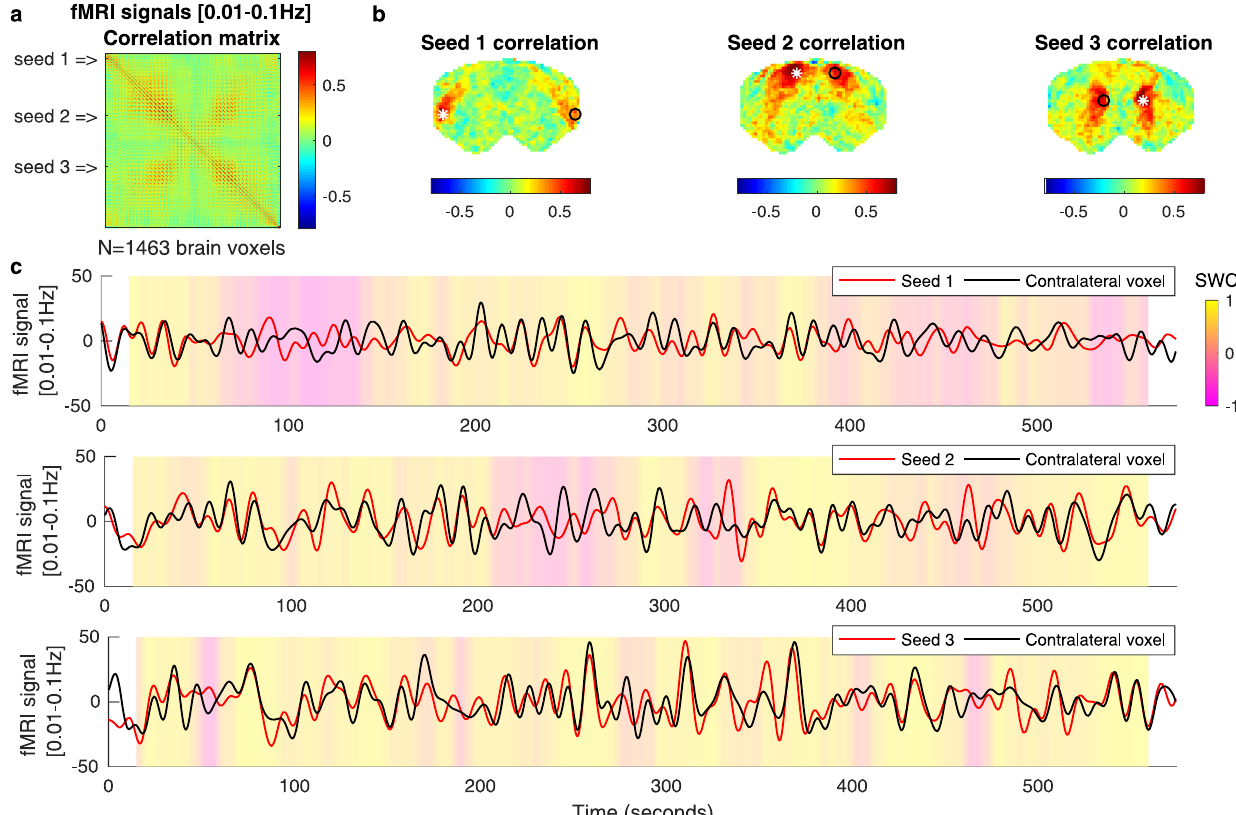
Fig. 1 | Static and dynamic resting-state functional connectivity analysis in band-pass fi ltered fMRI signals. a Correlation matrix of the fMRI signals in all voxels within the brain mask, bandpass fi ltered in a range typically considered in resting-statestudies,i.e.,0.01 – 0.1Hz(nonuisanceregressornorspatialsmoothing applied). Each line/column in the matrix corresponds to the correlation map of each voxel. b Seed-based correlation maps are represented for three different seeds (white asterisks), where each voxel is colored according to its degree of